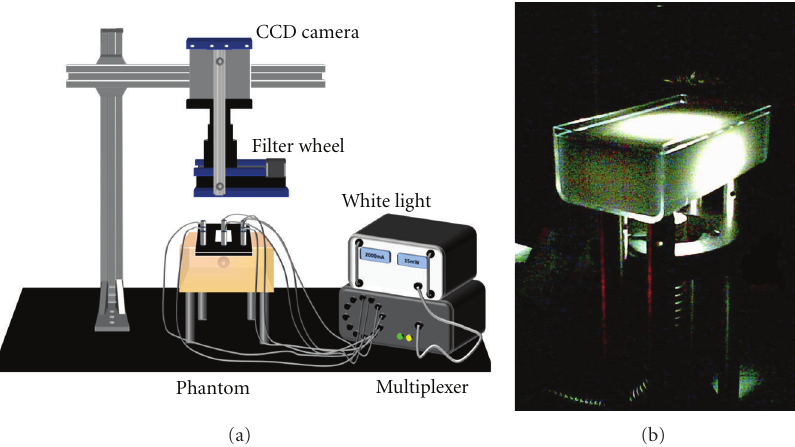
Figure 1: (a) Schematic diagram of a CCD-camera-based DOT system for laboratory measurement; (b) a tissue phantom which was sitting on the phantom supporter with the illumination light coming from the bottom.